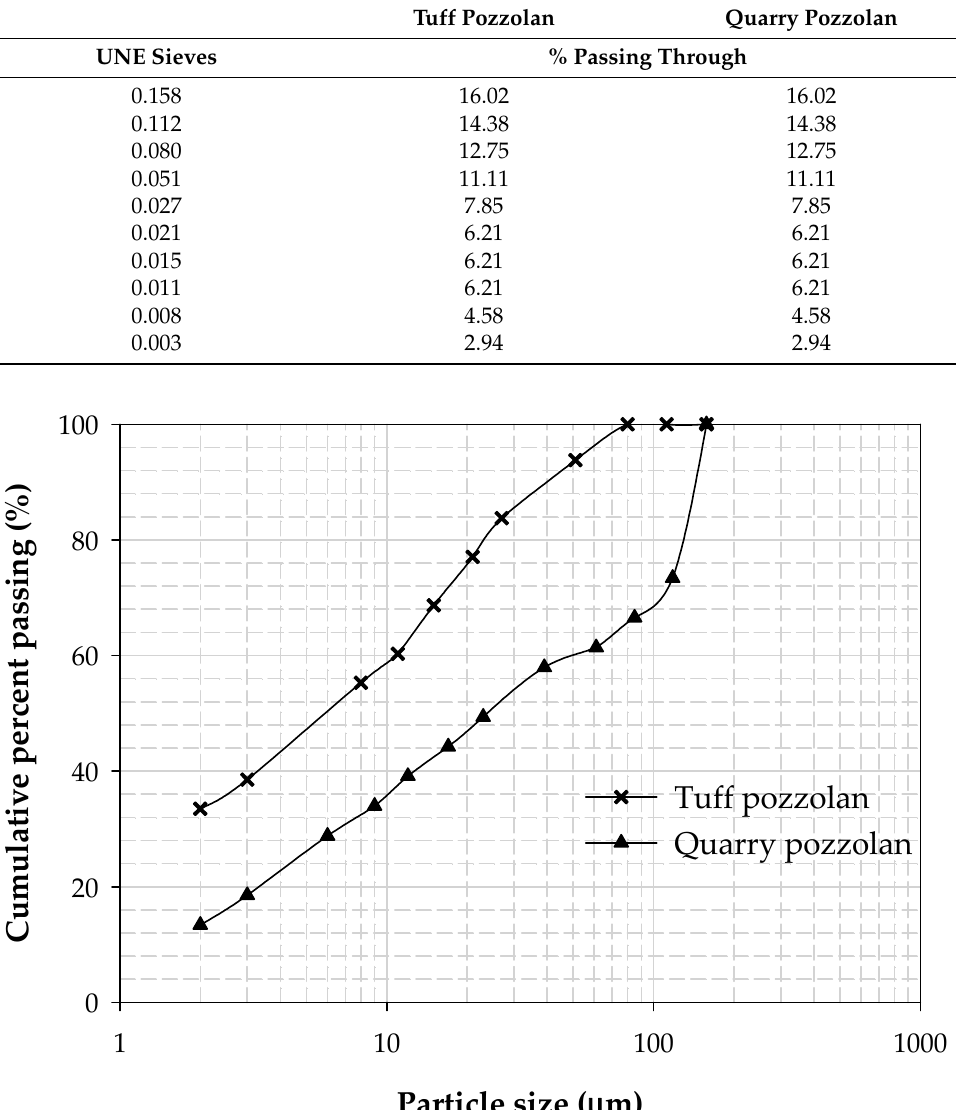
Figure 4. Particle size distribution of the used tuff and quarry pozzolans.